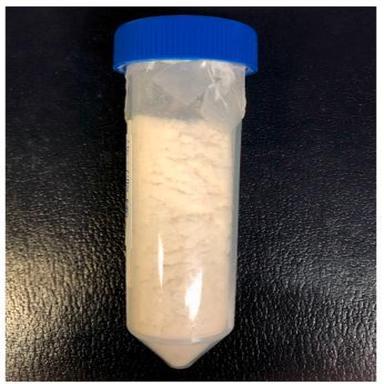
Freeze-dried CNC.